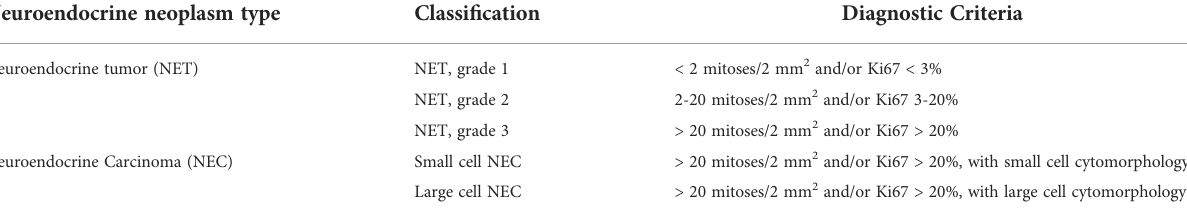
TABLE 1 The World Health Organization (WHO) Gastrointestinal and pancreatobiliary tract neuroendocrine neoplasms classi fi cation. Neuroendocrine neoplasm